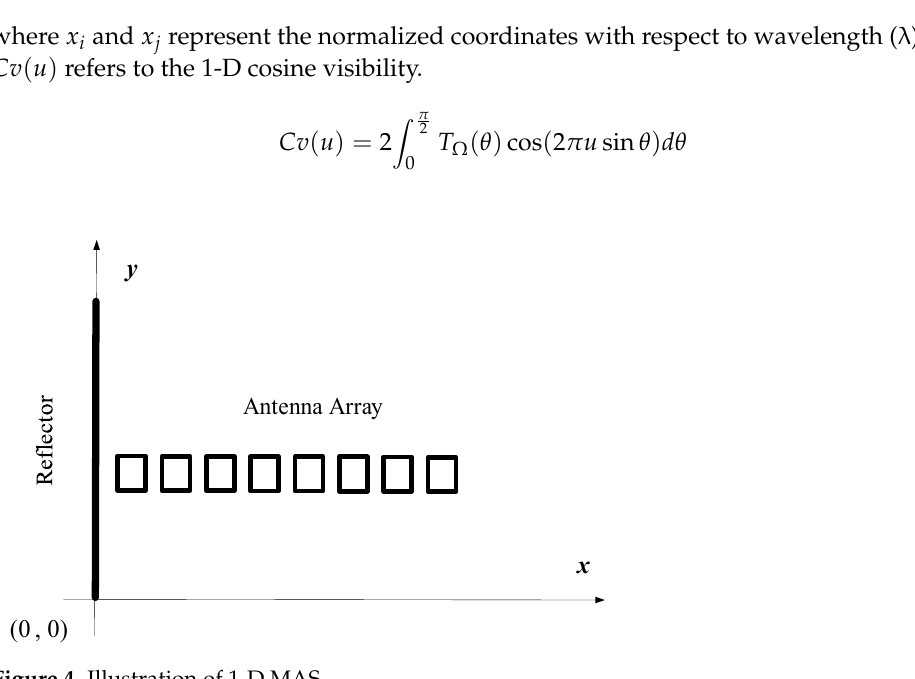
Figure 4. Illustration of 1-D MAS.